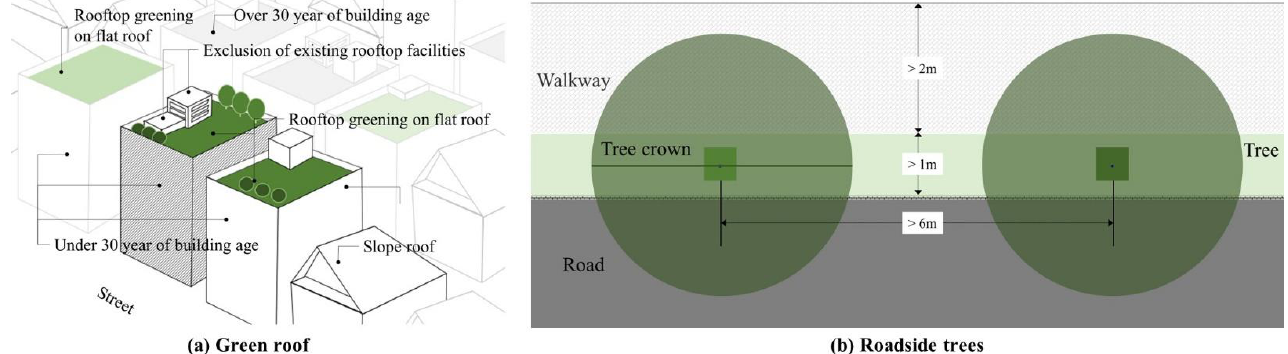
Figure 1. Conditions of suitable locations for rooftop greening and roadside planting. ( a ) Simplified 3D model for rooftop greening. ( b ) Simplified 2D model for roadside planting. Table 1. Analytical data for the study.